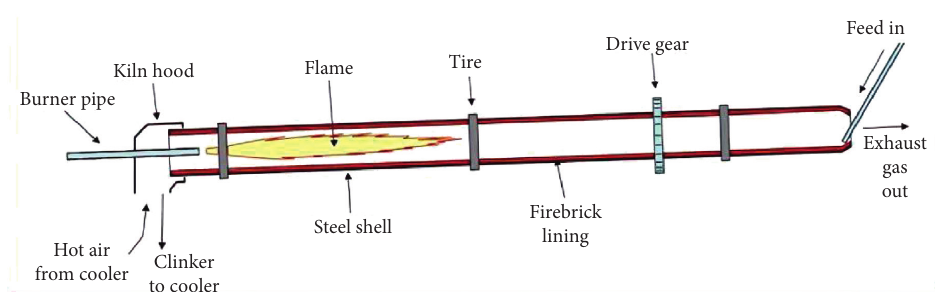
Figure 3: General layout of a rotary kiln